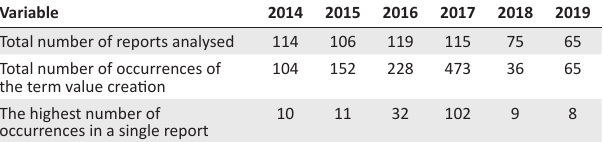
TABLE 1: Number of occurrences of the term ‘value creation’ per year.